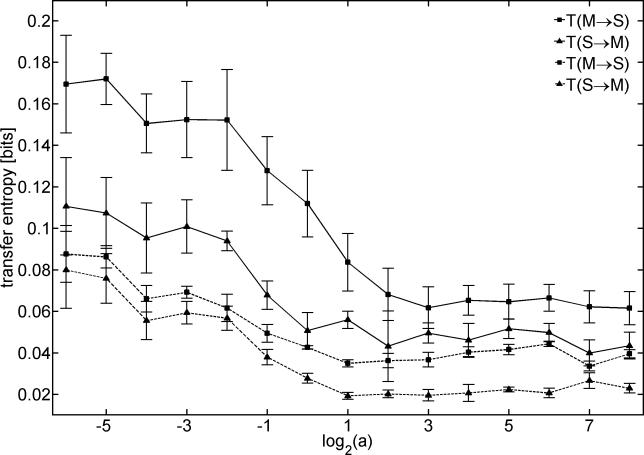
Effect of Retinal Morphology on Information FlowTransfer entropy between sensor (S) and motor variables (M) as a function of parameter a in Madame. The linear parameter a determines the distribution of the photoreceptors in the retina and thus the eye morphology. Transfer entropy is calculated for every pixel of a visual region (S; 6 × 6 pixel patch) and the difference between left and right wheel speed (M; angular velocity). Squares show information flow from M to S; triangles indicate information flow from S to M. Pixels were selected from a central visual region (continuous lines) and a peripheral region (dashed lines). Data in all graphs are averages of five representative experiments consisting of 4,096 samples each, error bars show standard deviations.